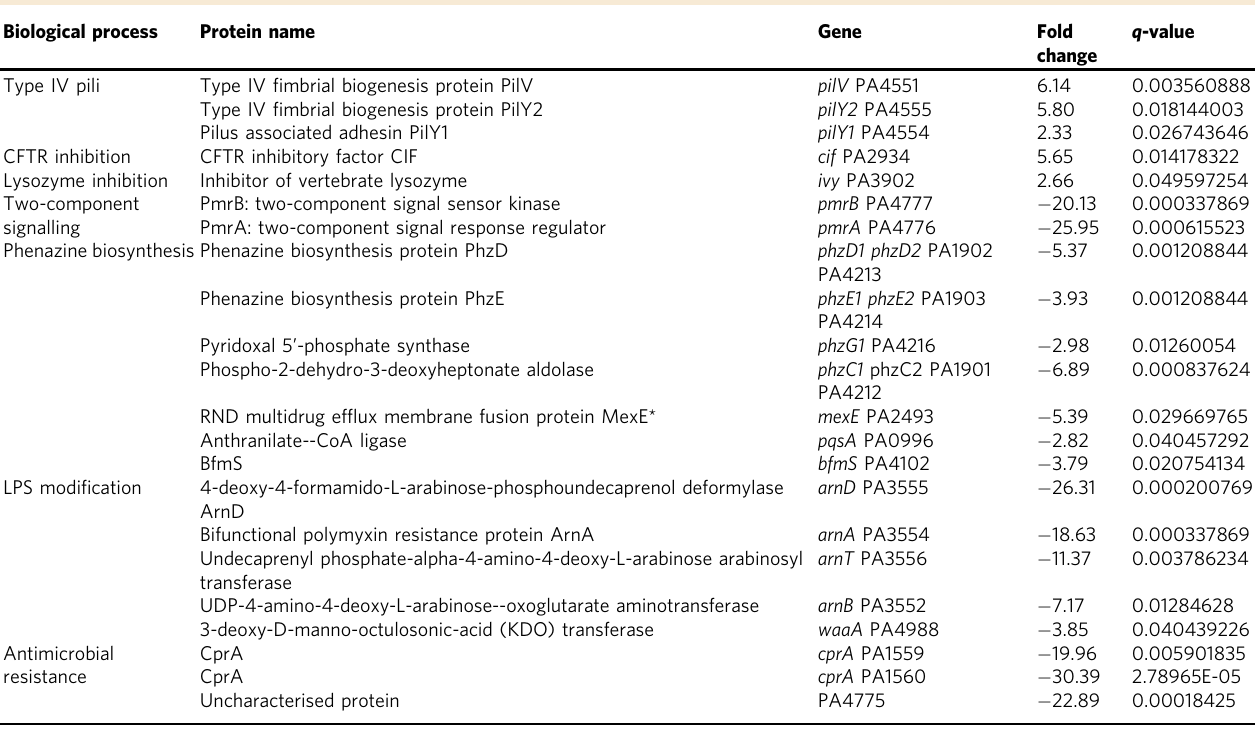
Proteins dowregulated in Δ pmrB relative to LESB65 are denoted with a minus fold-change *MexE is also involved in antibiotic